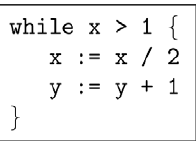
Figure 3. Pseudo-code to implement the logarithm